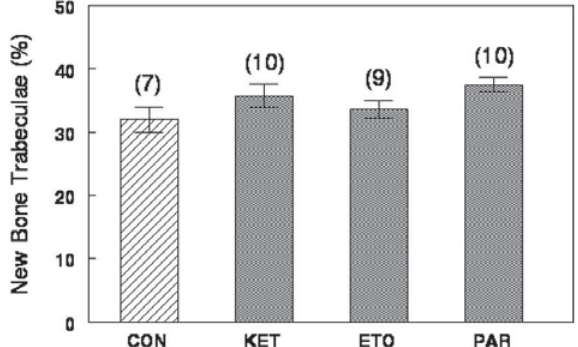
Figure 2- Percent of new bone trabeculae (mean (cid:3) standard error of mean) inside the alveolar socket, 2 weeks after tooth extraction, in control (CON) rats and in rats treated with ketorolac (KET), etoricoxib (ETO) and paracetamol (PAR)